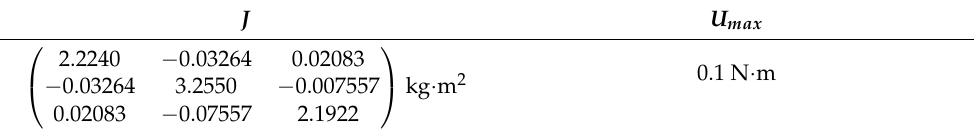
Table 6. Satellite parameters.